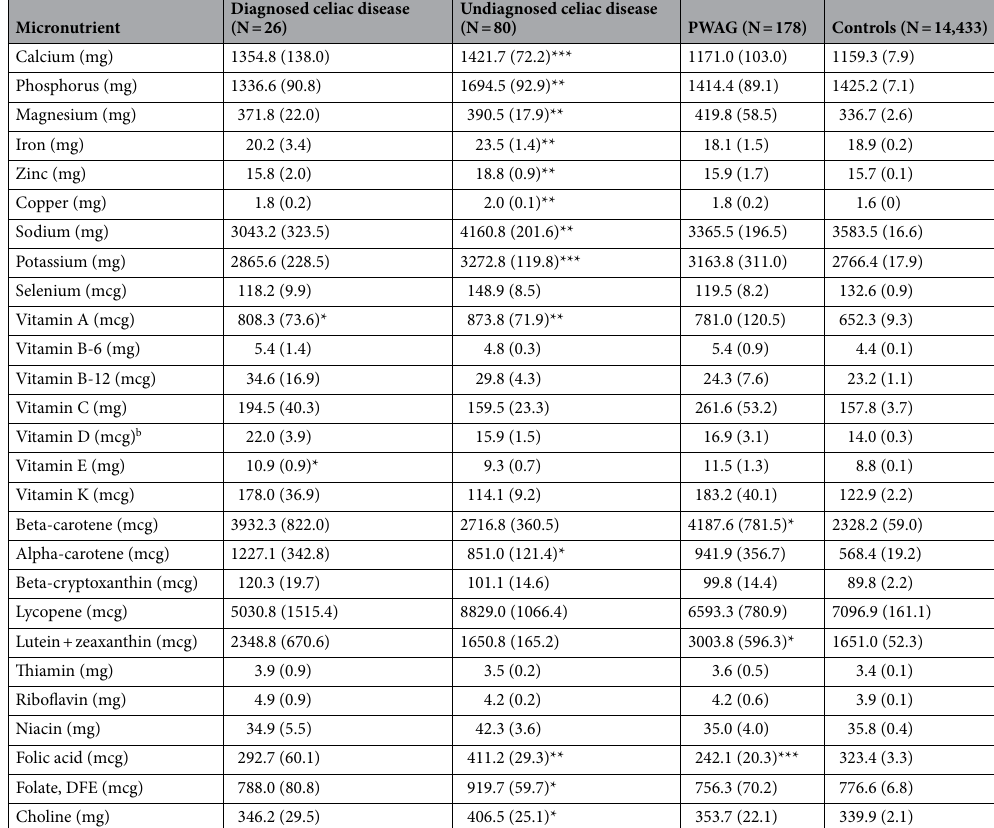
Table 4. Adjusted a mean (SE) micronutrient intake from food and supplements among NHANES participants 20 years and older with and without celiac disease and PWAG, United States, 2009–2014. NHANES, National Health and Nutrition Examination Survey; PWAG, persons without celiac disease avoiding gluten; SE, standard error. a Adjusted for age, sex, and race/ethnicity. b Vitamin D2 + vitamin D3. * p < 0.05, ** p < 0.01, and *** p < 0.001 compared to